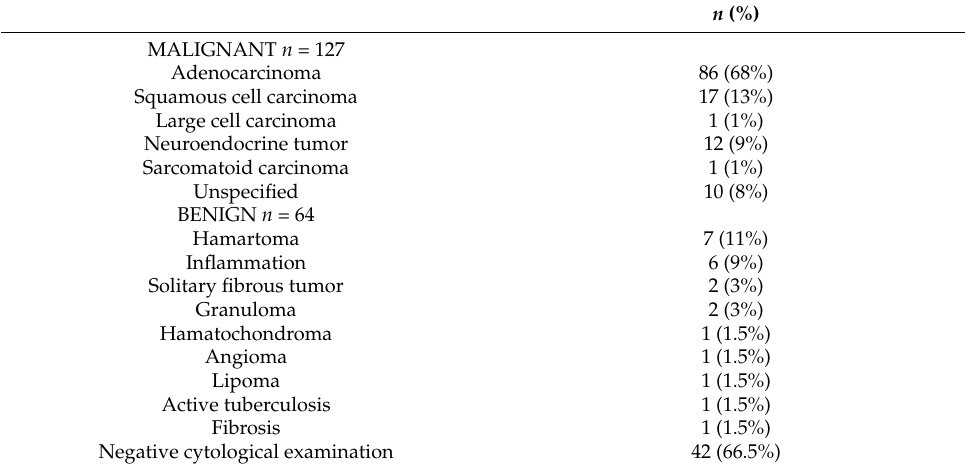
Figure 3. A 77-year-old male with a SPN of 22 mm of diameter in the right lung and increased FDG uptake ( A – D ). Another case of a 54-year-old female with a 12 mm lung nodule in the inferior lobe of the left lung without significant FDG uptake ( E – H ). Table 2. Final histological/cytological diagnosis of